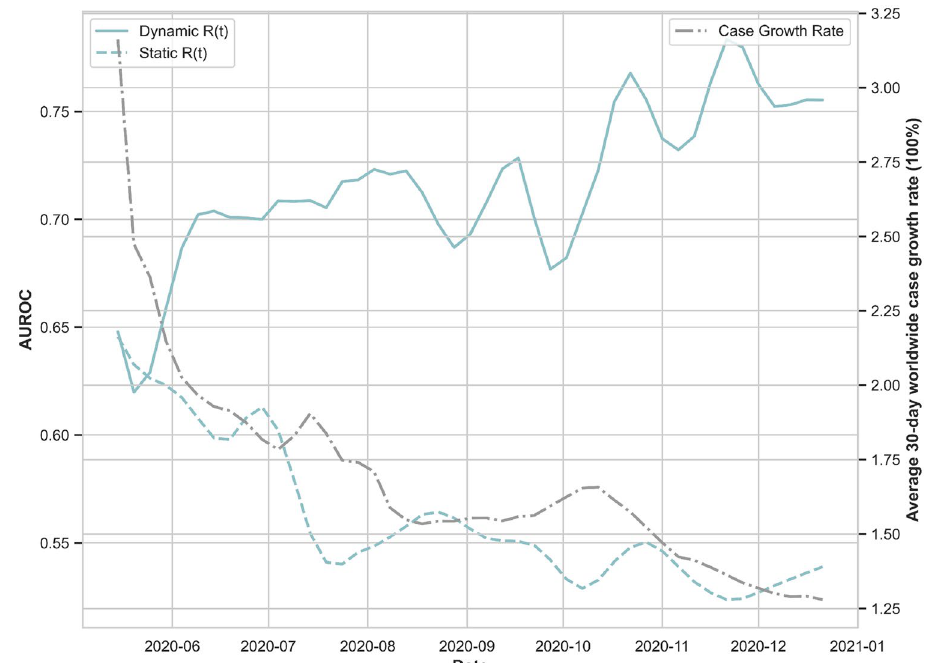
Figure 4. Outbreak prediction accuracy of the stochastic SEIRD model with dynamic and static effective reproduction numbers. This figure depicts the AUROC corresponding to 30-day outbreak predictions over 230 daily rolling windows from 15 May 2020 to 31 Dec 2020, and averaged over the selected 101 countries. The solid blue line corresponds to forecasts using the daily updated reproduction number averaged over the last five days previous to the time of prediction. The dashed blue line corresponds to forecasts in which the daily reproduction number remains static as the average over 11–15 May